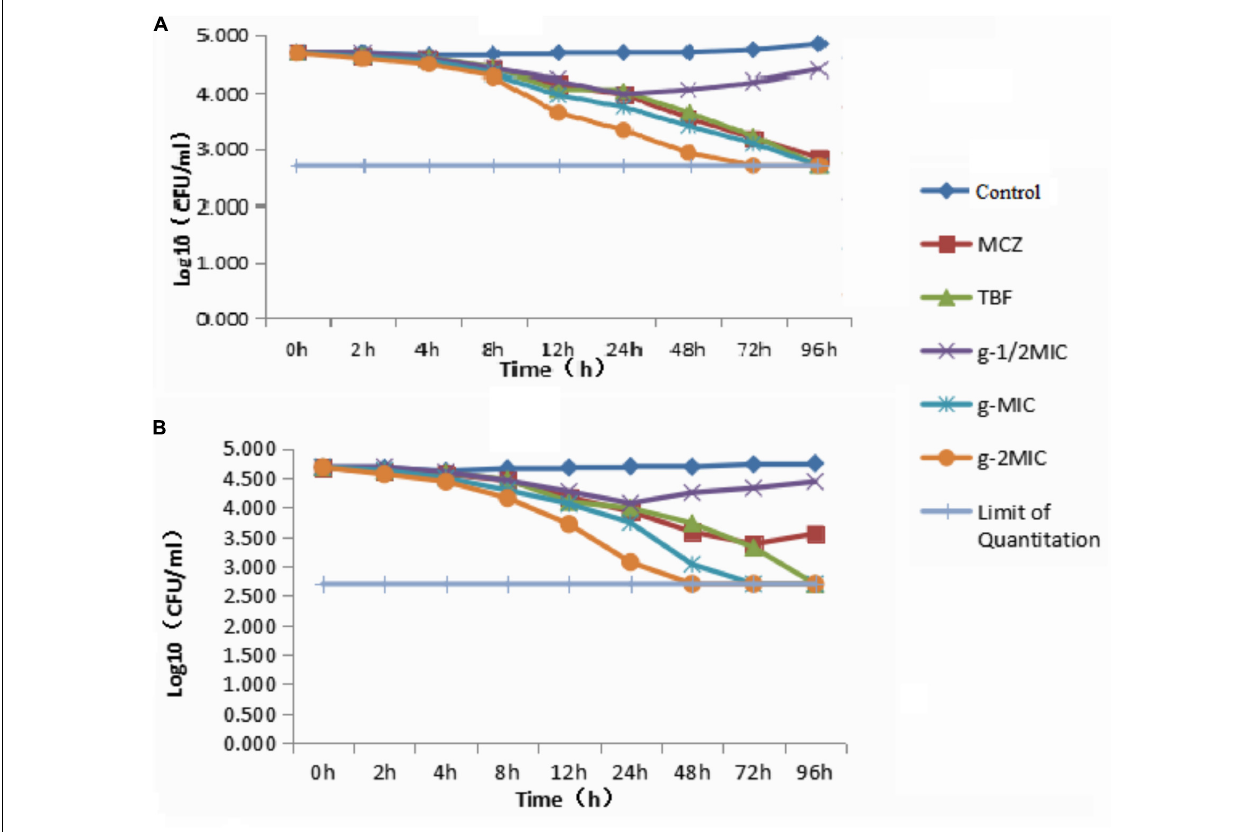
FIGURE 2 | Time-kill curve: (A) Time-kill curve of compound e against Microsporum canis ; (B) time-kill curve of compound g against M. canis. (The limit of quantitation indicated that there was no colony growth on plate medium.)